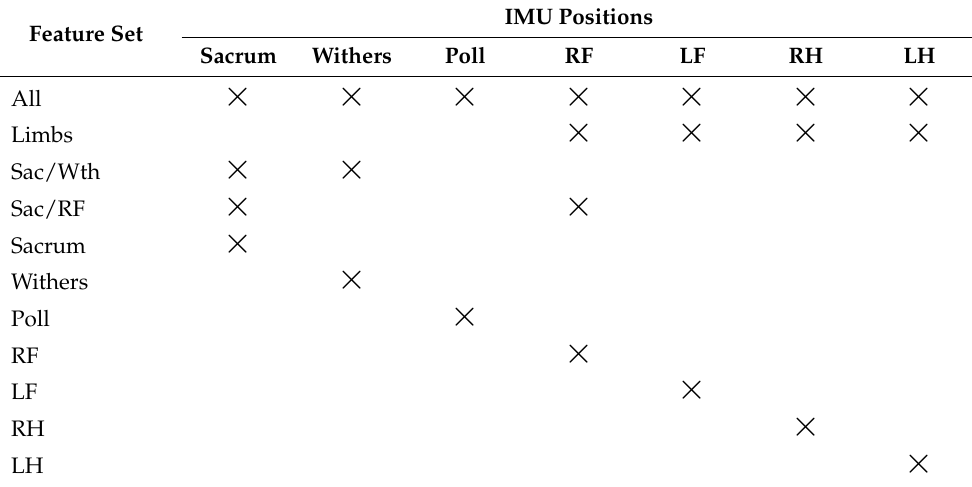
Table 2. Feature sets